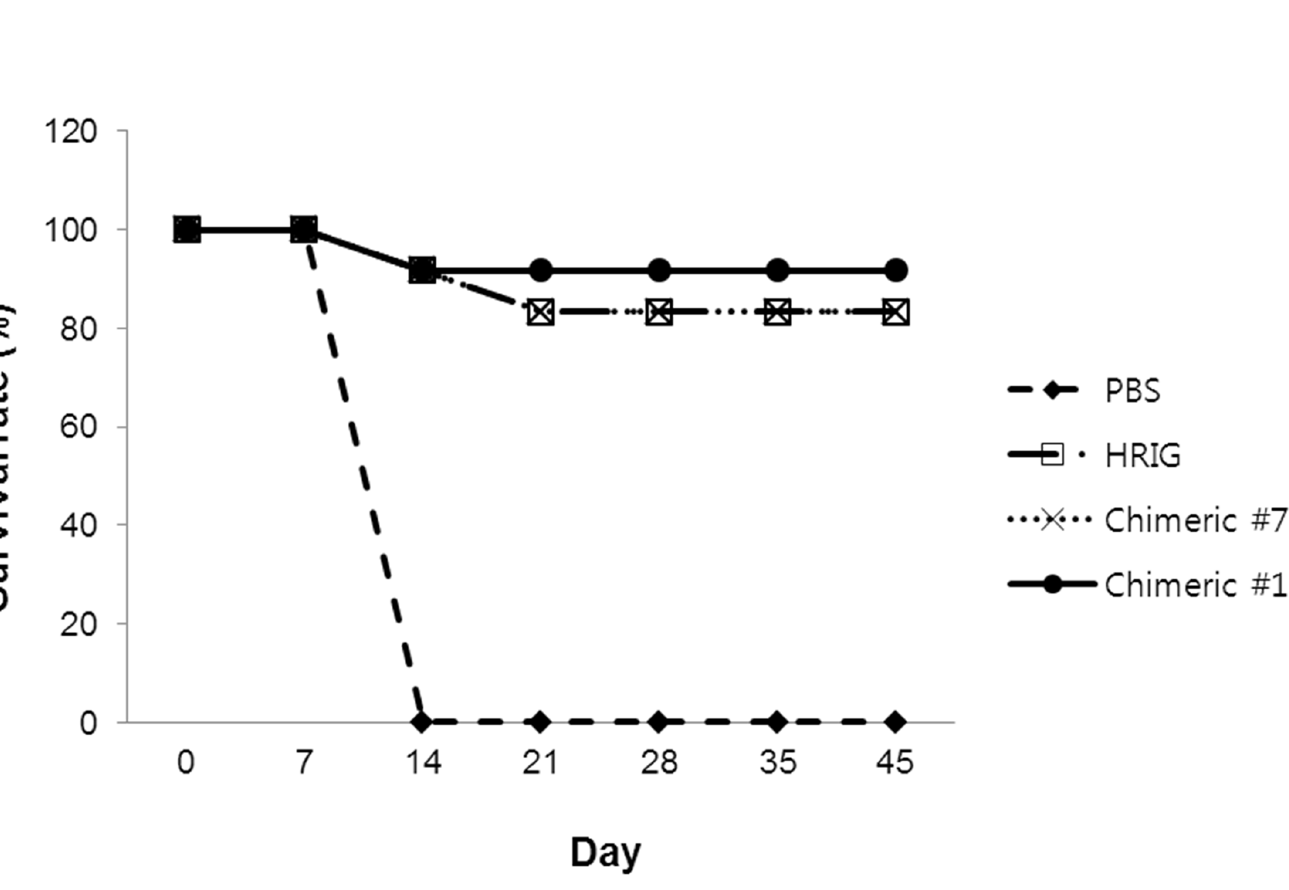
PLOS ONE | https://doi.org/10.1371/journal.pone.0186380 October 18, 2017 13 /